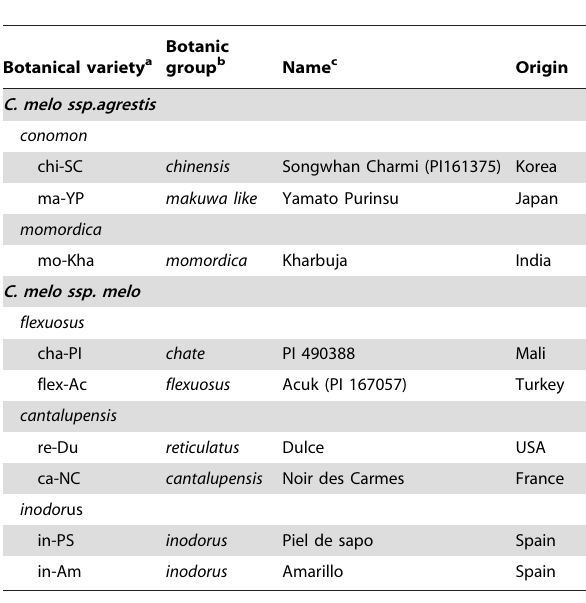
Table 1. List of accessions studied and their